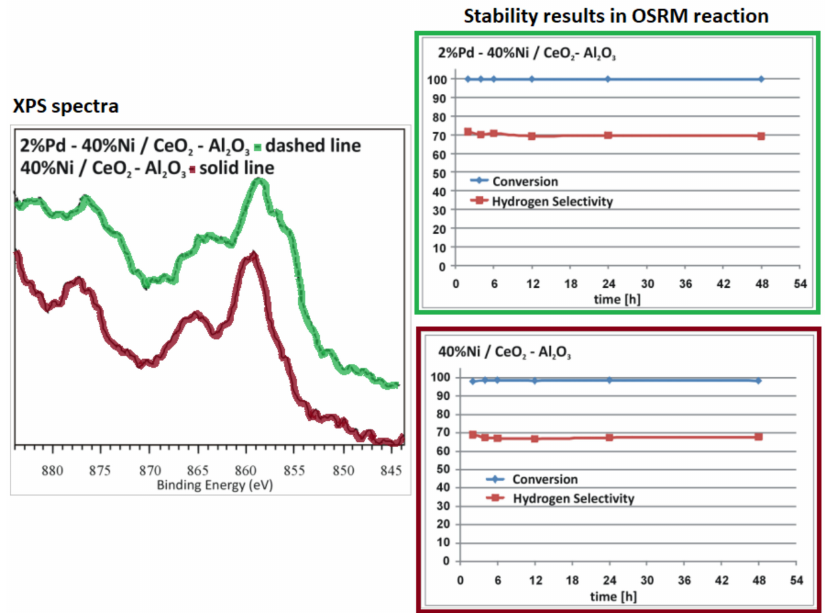
Figure 7. XPS and stability results during 48 h of the OSRM reaction performed at 250 ◦ C after reduction 1 h at 300 ◦ C [23].